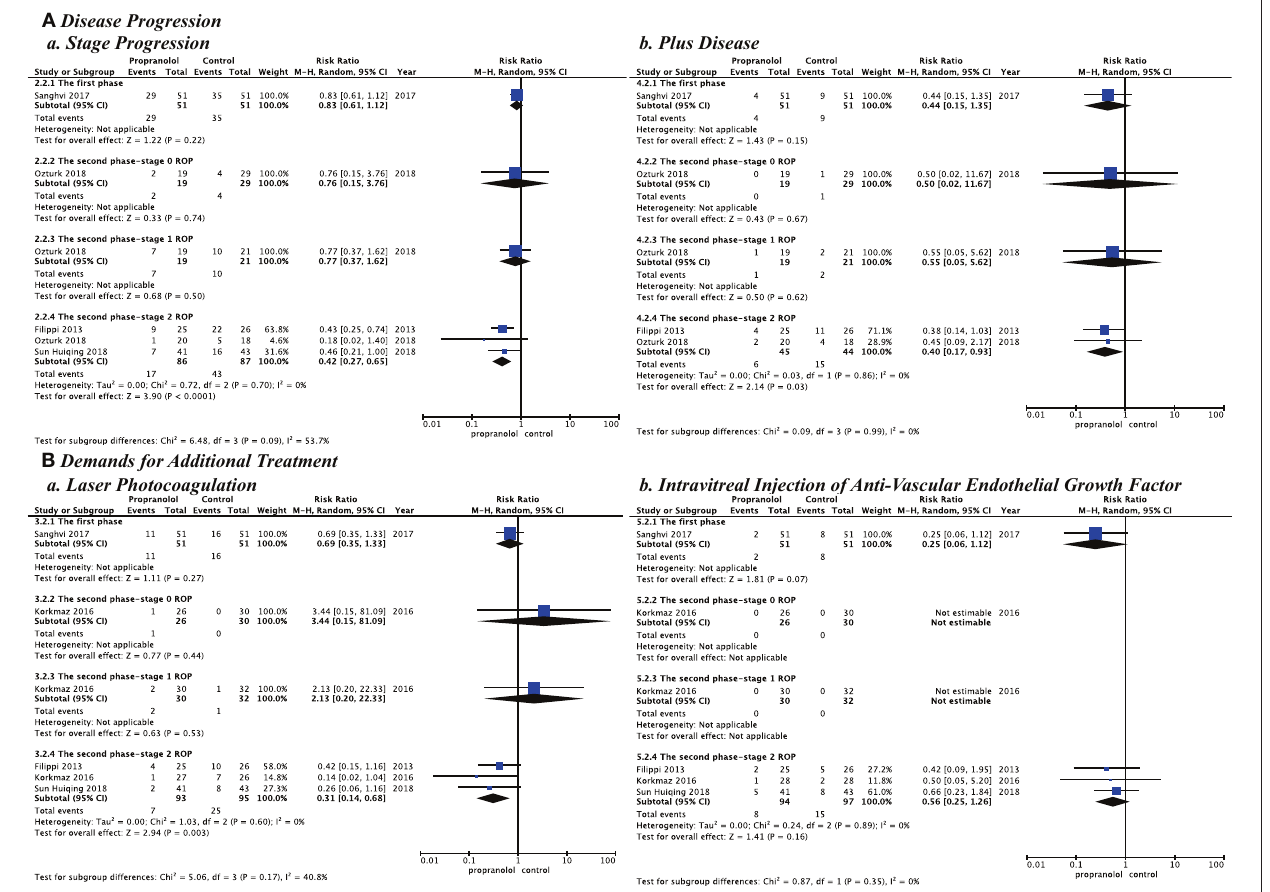
FIGURE 5 | Subgroup analysis with different retinopathy of prematurity phase and stage when starting to prevent or treat. (A) Disease progression and (B) Demands for additional